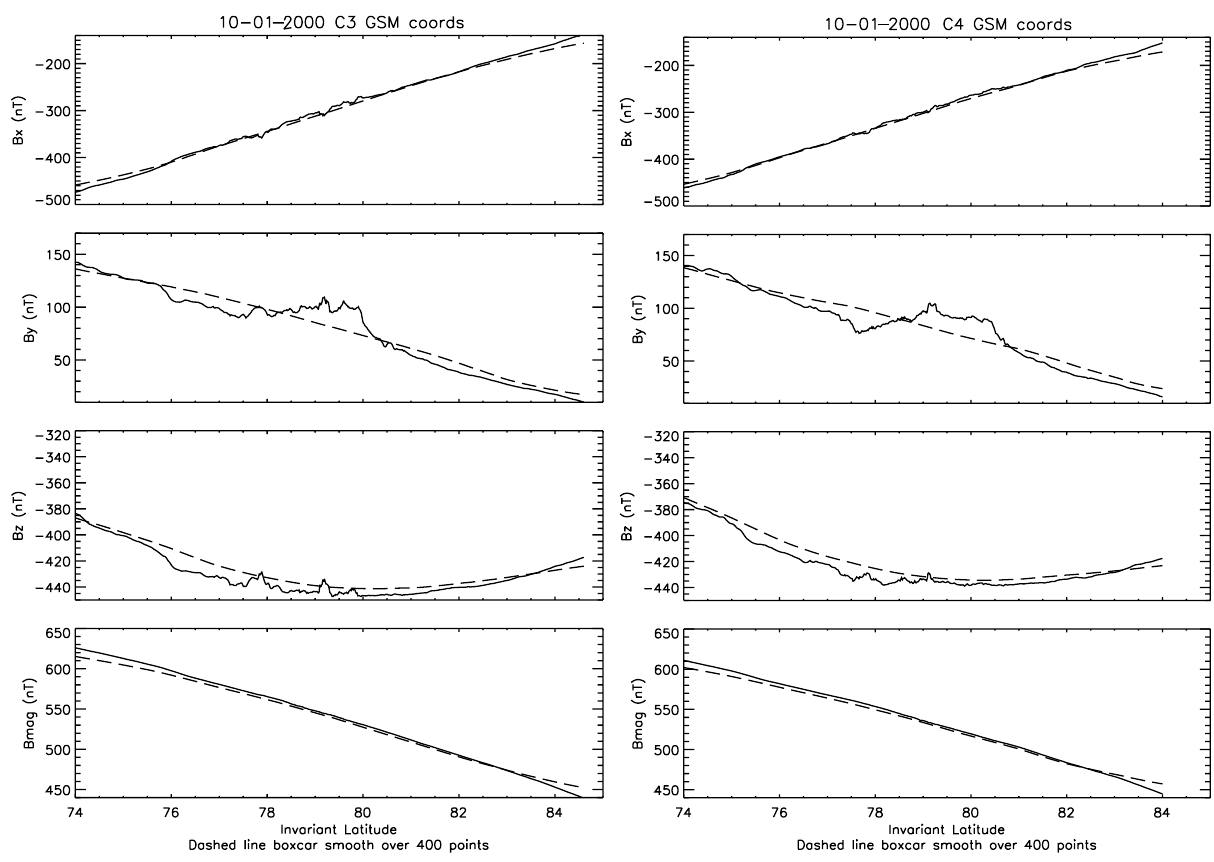
Fig. 4. The three components and magnitude of the total magnetic field (solid line) in GSM coordinates and the background magnetic field (dashed line), (a) from Cluster 3 and (b) from Cluster